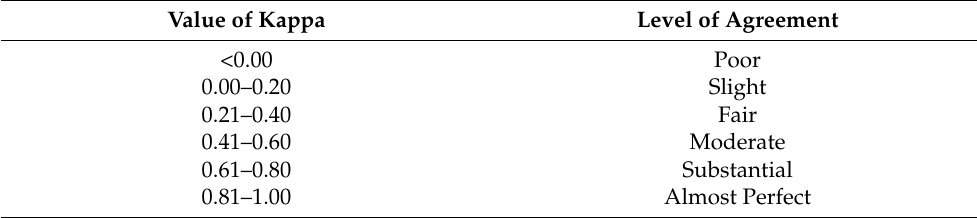
Table 4. Classification quality based on the Kappa coefficient